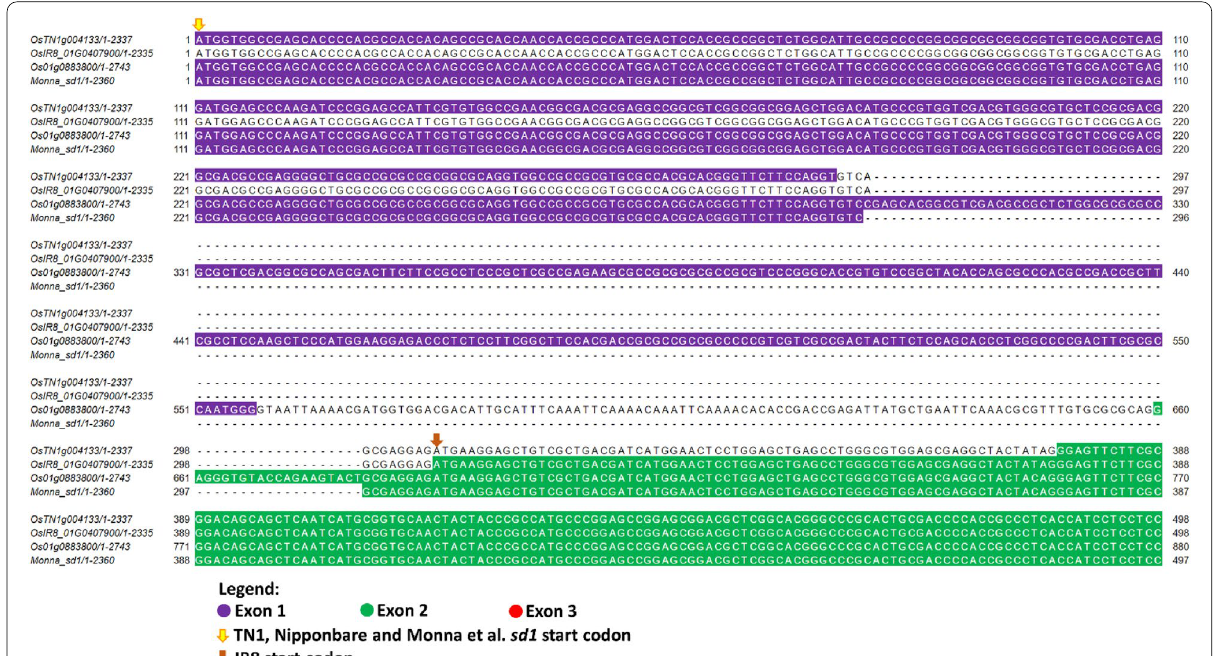
Fig. 1 Portion of the Clustal alignment of the sd1 exon sequences in TN1, IR8 and Nipponbare. Position 1 is the first nucleotide of exon 1 of the gene. For TN1, IR8 and Nipponbare, position 1 is located at 40,361,934; 39,824,196; and 38,382,466, of chromosome 1, respectively. OsTN1g004133, OsIR8_01G0407900 and Os01g0883800 refer to the sd1 gene IDs of TN1, IR8 and Nipponbare, respectively. Beside the gene IDs are the positions of the first base and last base of the sequence, with the latter representing its total length. The total sequence length as well as the start and end positions of each exon are depicted in Fig. 2. Deleted nucleotides are represented by dashes. The location of the first base of the start codon is indicated by an arrow pointing downwards. Exons are colored whether they are the first, second or third exon. Nucleotides in introns are uncolored, except for the sequence before the start codon of IR8, which was assigned as a 5 ′ untranslated region in its